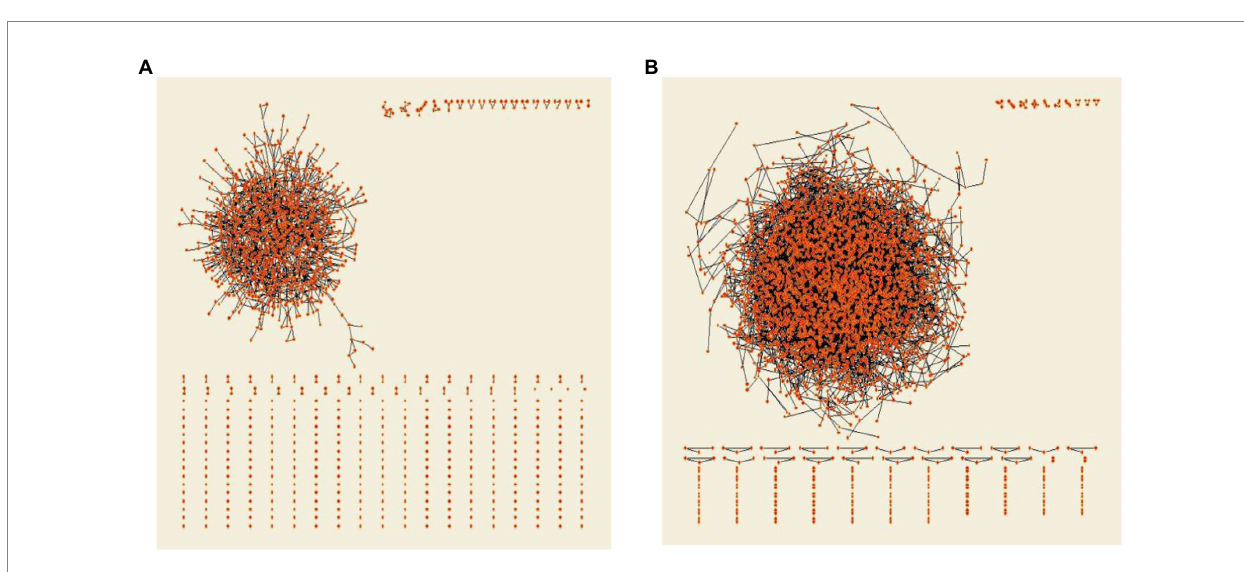
FIGURE 3 Comparison of interlocking director network of listed companies in 2007 and 2020. (A) Interlocking director network of Chinese A-listed companies in 2007. (B) Interlocking director network of Chinese A-listed companies in 2020.